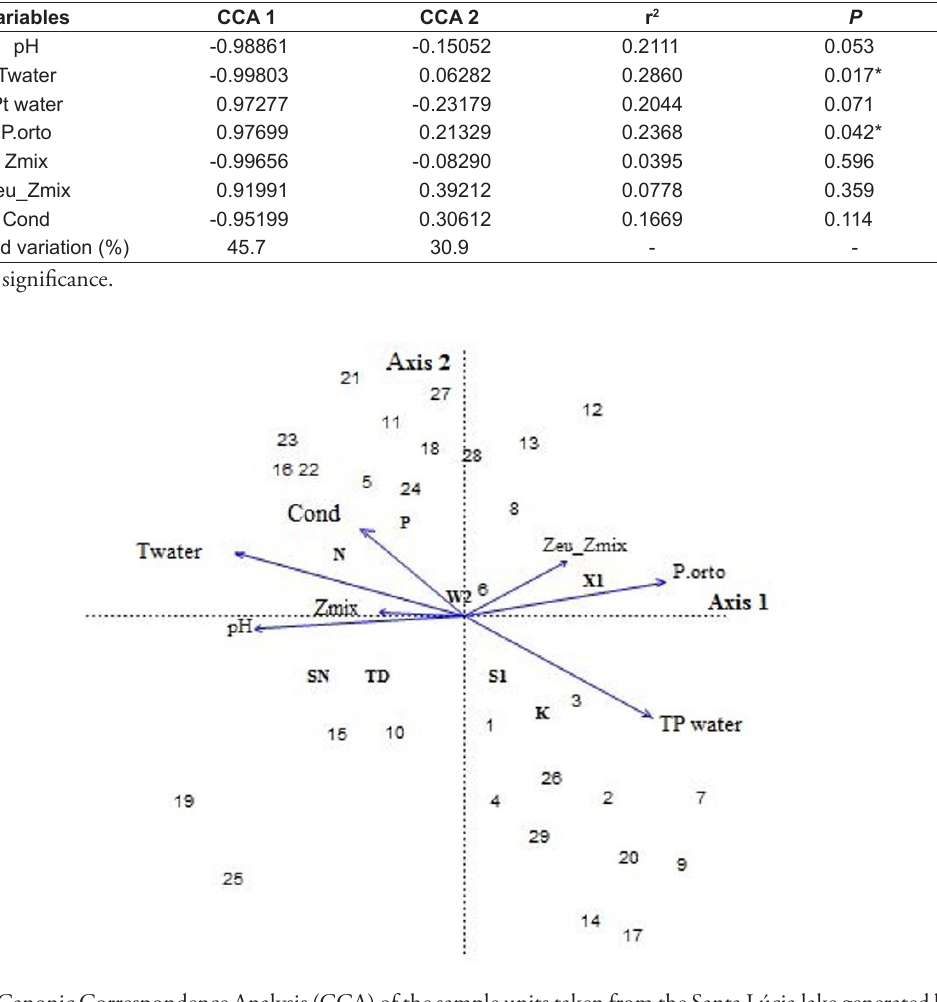
Figure 4. Canonic Correspondence Analysis (CCA) of the sample units taken from the Santa Lúcia lake generated by seven abiotic variables and the descriptive functional groups of the phytoplankton community. The numbers indicate the months and sampling points. Aug (1-3), Set (4- 6), Out (7-9), Dec (10-12), Jan (13-14), Feb (15-17), Mar (18-20), Apr (21-23), May (24-26), Jun (27-29). The limnological variables: Twater = water temperature, Cond = Conductivity, pH, Zeu:Zmix, P.orto = orthophosphate, PTwater = total phosphorus, K = light attenuation